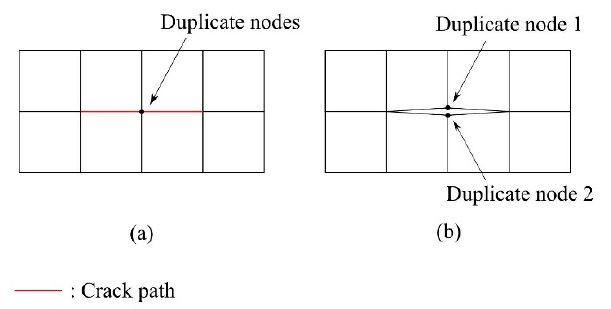
Figure 6. ( a ) Representation of a crack by introducing duplicate nodes on the crack path; ( b ) Crack- representation by separating the relevant edges of the elements in the mesh.